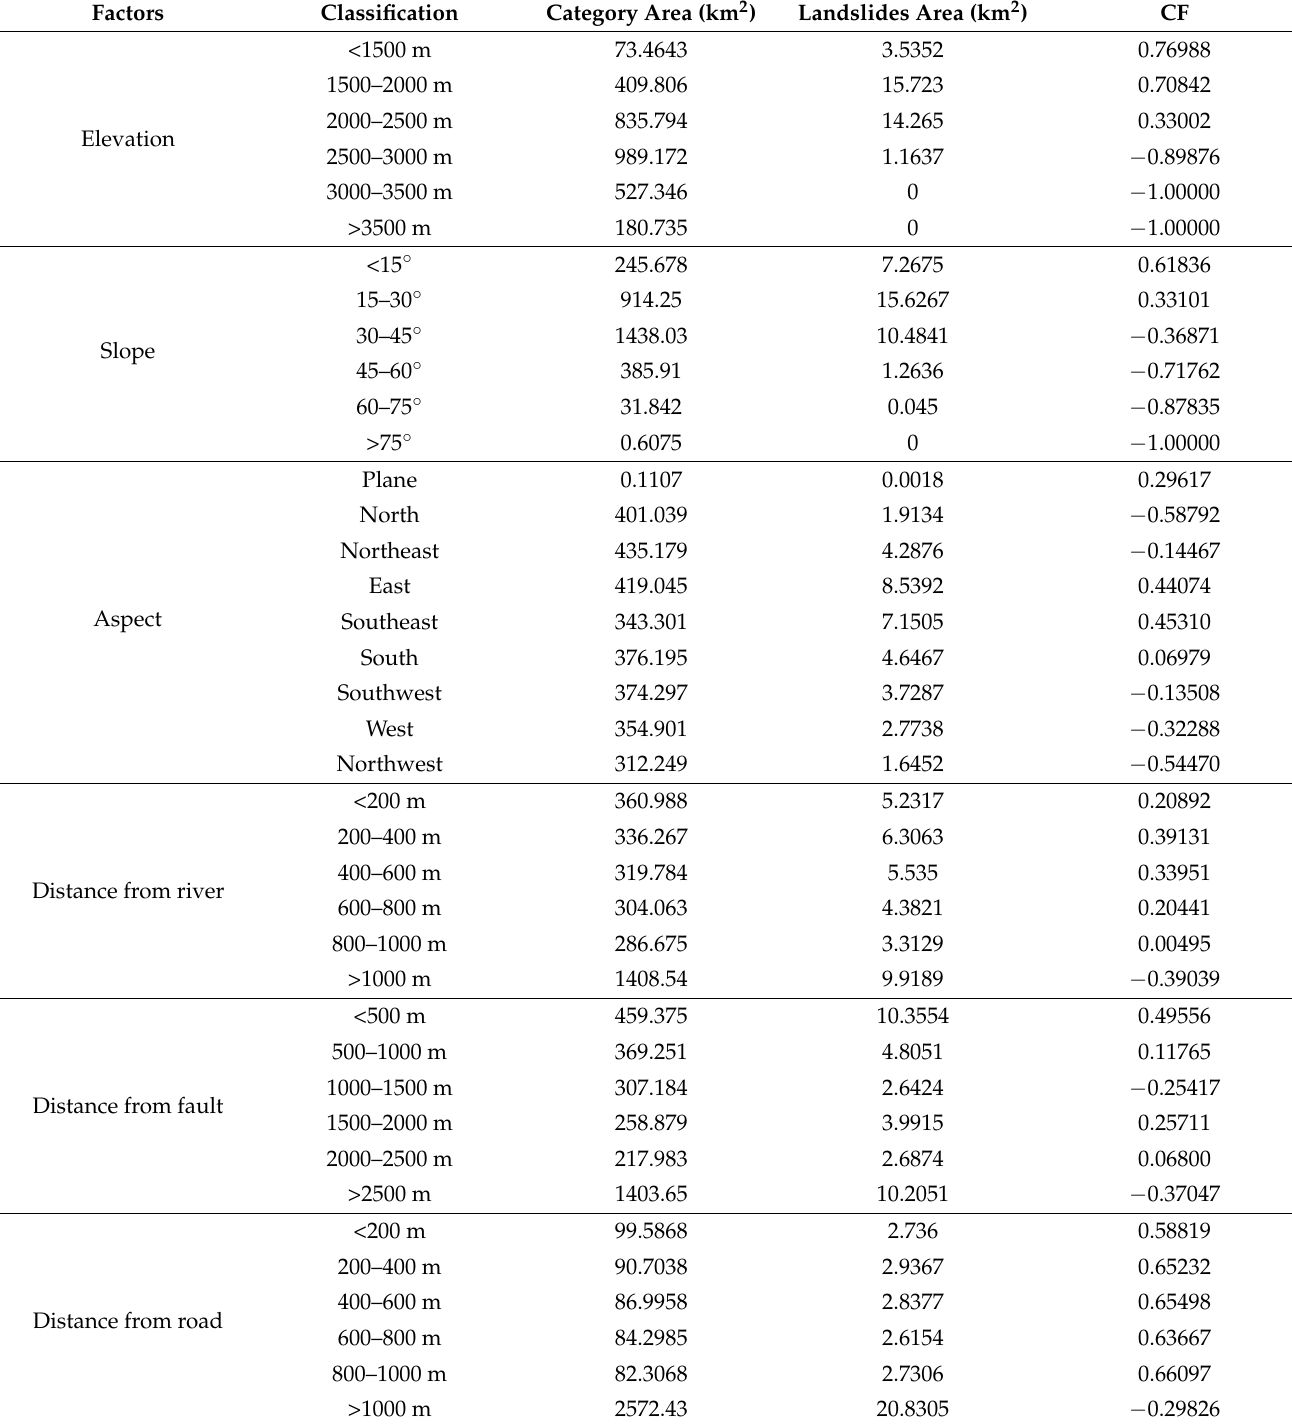
Table 5. CF values obtained for different classes of the seven factors influencing landslides in